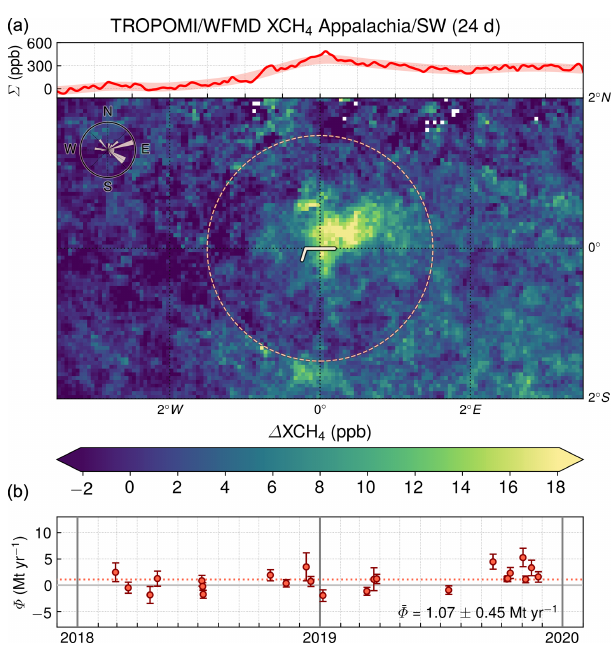
Figure 7. As Figs. 4 and 5 but for the southwestern part of the Appalachia region. The coordinates of the pivotal point are 40 ◦ N, 80 ◦ W. The pivotal point of the second subregion not shown here is located at 41 . 8 ◦ N, 76 . 6 ◦